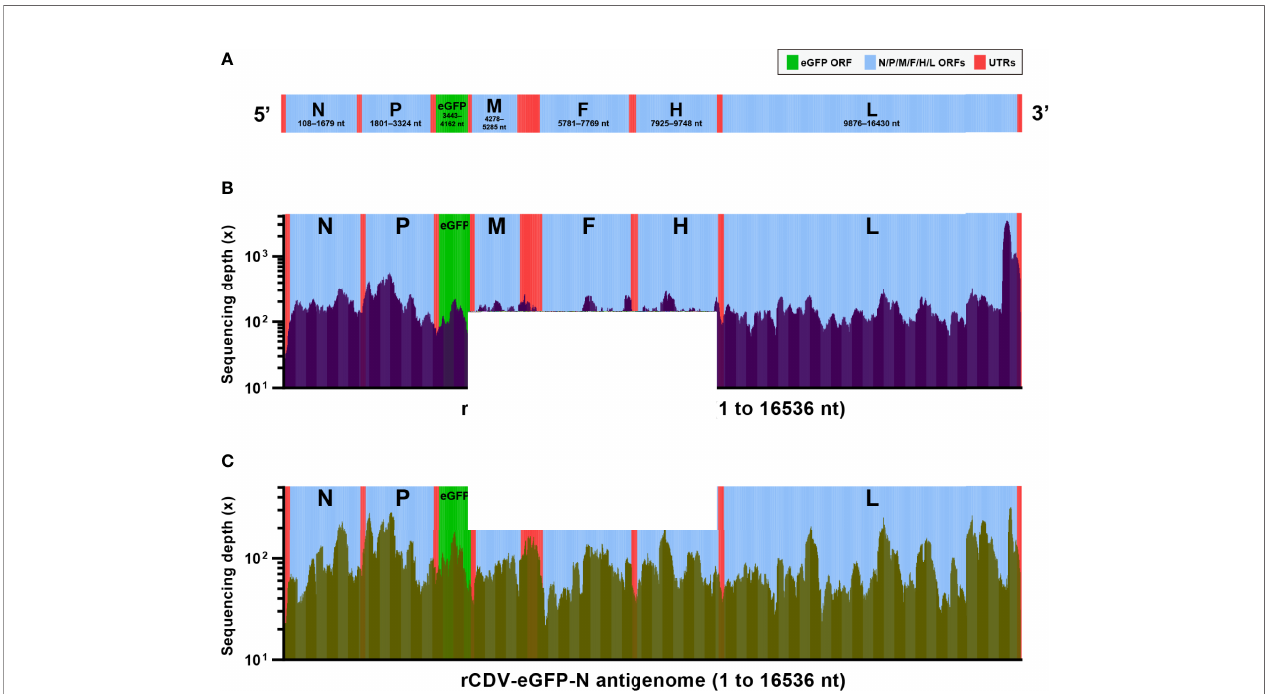
FIGURE 2 | Next-generation sequencing of rCDV-eGFP-R and -N at P47. Schematic representation of rCDV-eGFP antigenome (A) . All elements proportionally match their actual lengths in viral antigenome. ORF, open reading frame; UTR, untranslated region. Depth and coverage of next-generation sequencing across the rCDV-eGFP-R (B) and -N (C) antigenomes. All elements proportionally match their actual lengths in viral